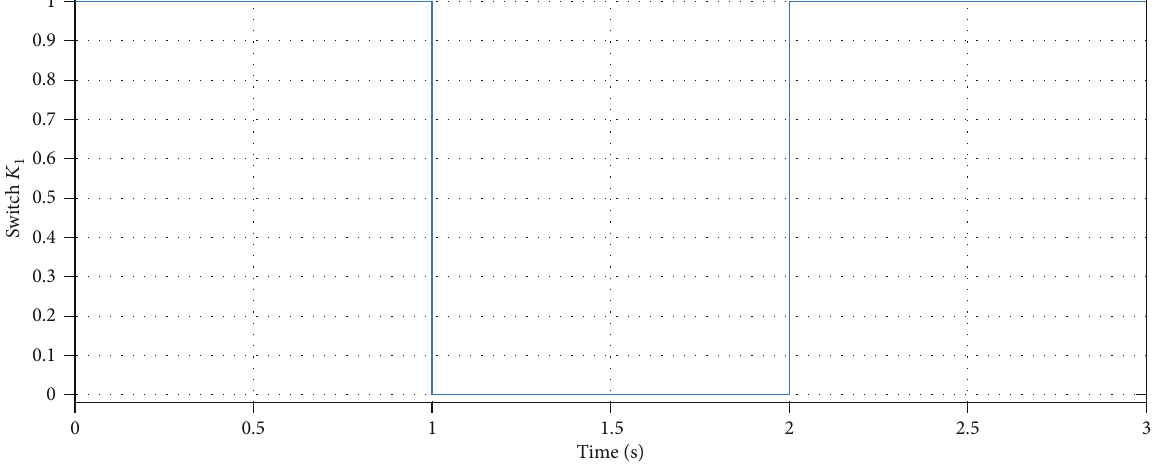
Figure 11: Switch K